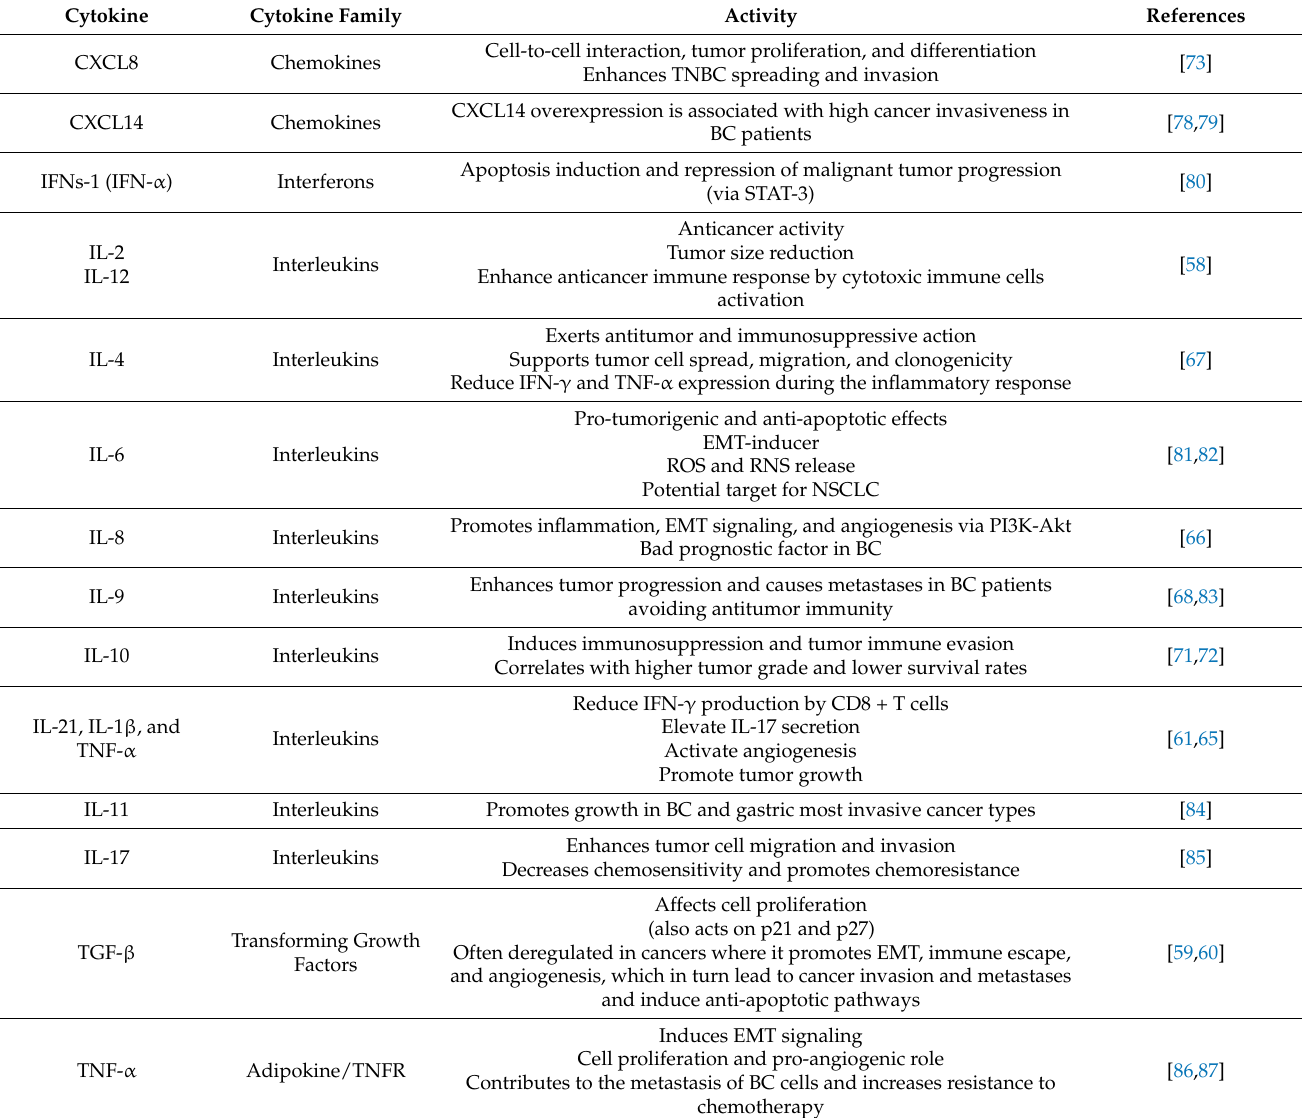
Table 1. Functional roles of pro-inflammatory cytokines in tumor progression and immune response.